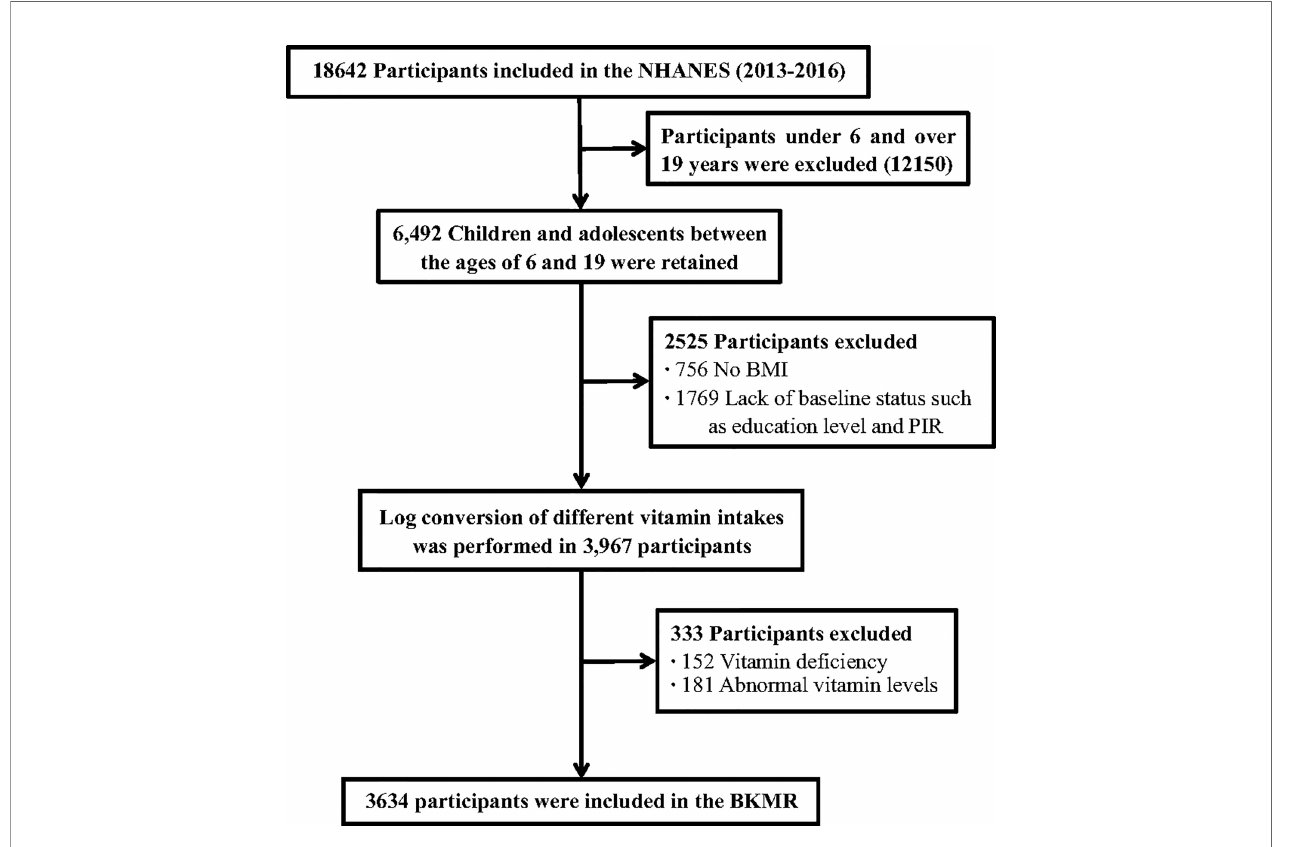
FIGURE 1 | Selection process of subjects. BKMR, Bayesian kernel machine